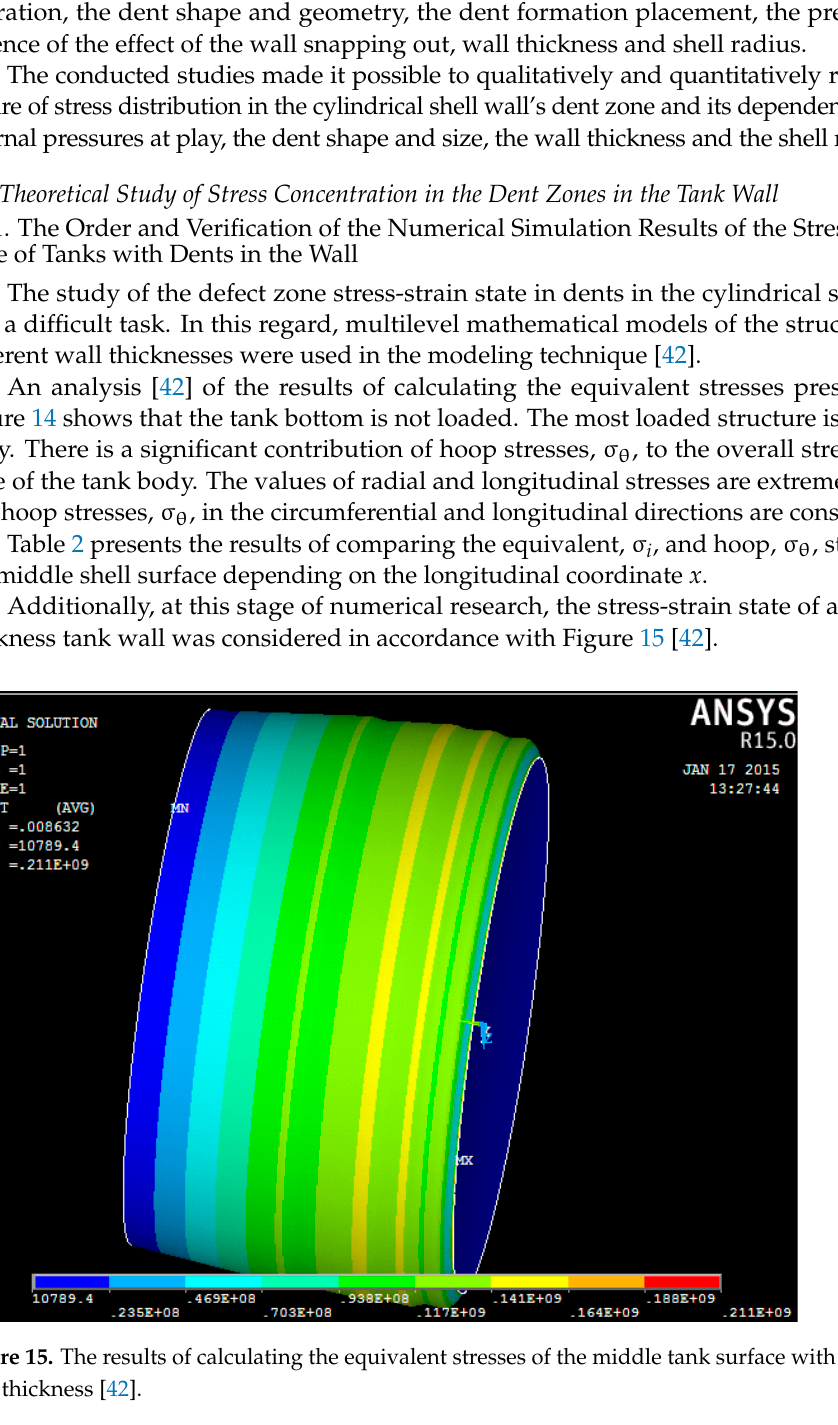
Table 3. The results of comparing the calculated values of the equivalent, σ i , and hoop, σ θ , stresses in the tank wall.